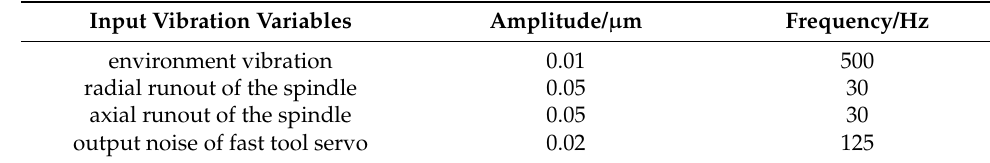
Figure 7. Complete Simulink model of the dynamic response. Table 4. Input vibration variables of the simulation model.